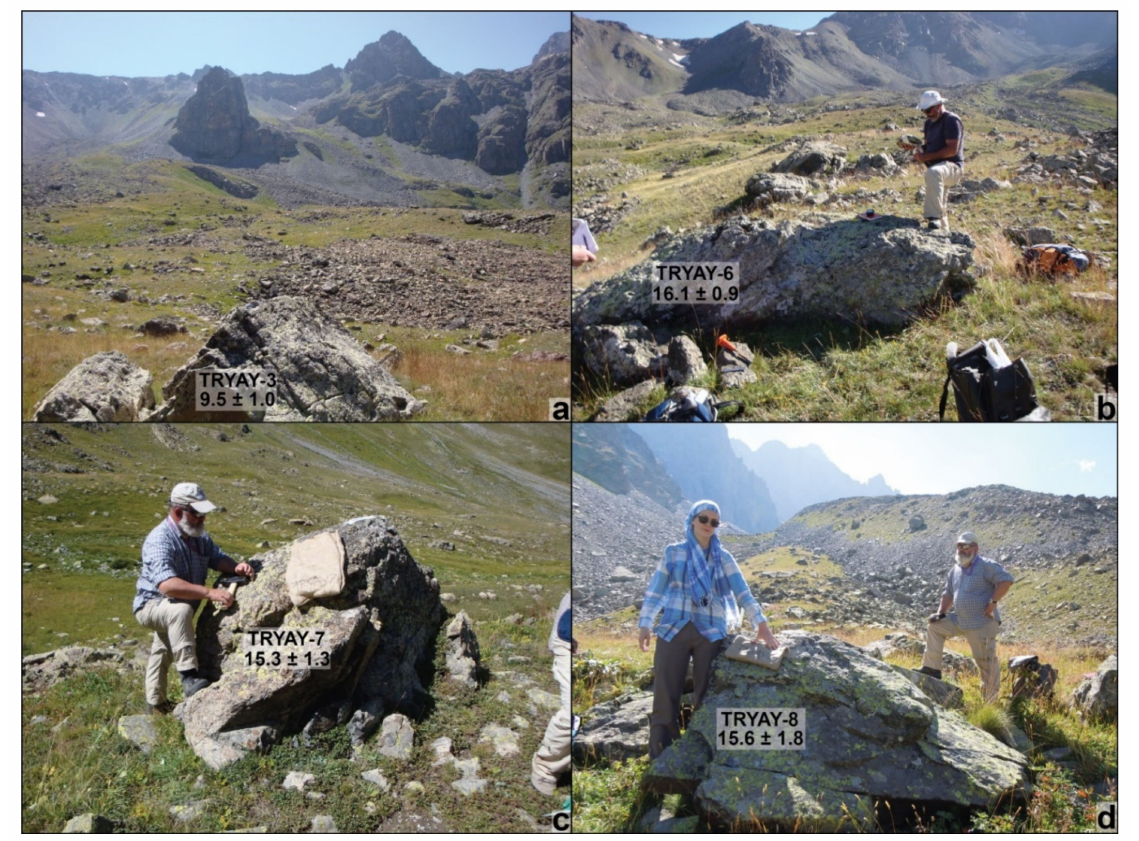
Figure 10. Landscape and sampled boulders in the upper cirques. ( a , b ) Uppermost Hastaf Valley as seen from sample position TRYAY-3 and TRYAY-6, respectively. ( a ) View to the west with a pronounced horn morphology and with undifferentiated glacial morphologies throughout the broad cirque. ( c , d ) Sampled boulders and landscape in uppermost Dübe